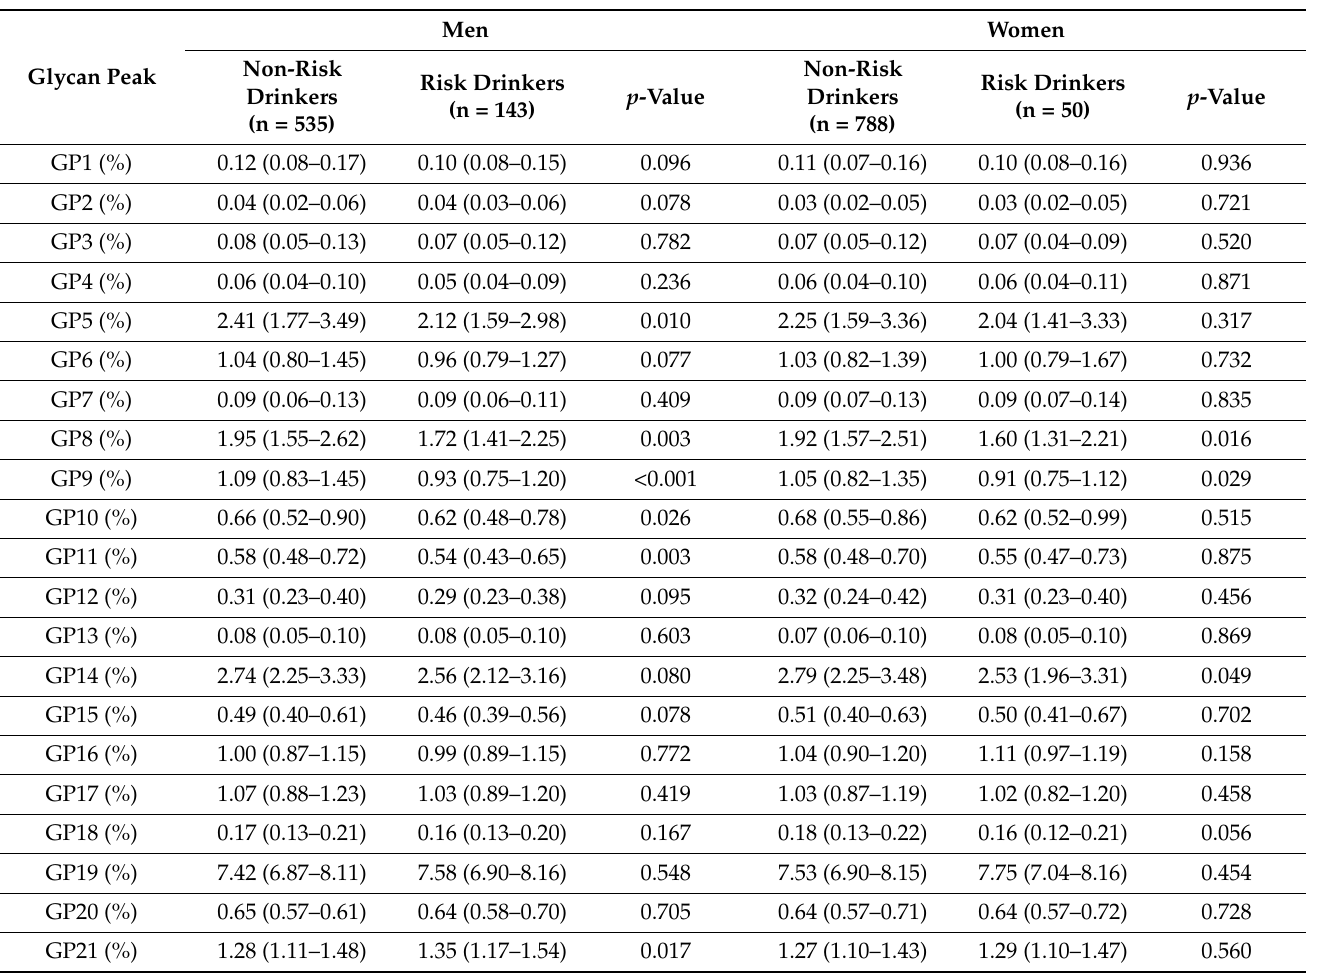
Table 3. Comparison of N -glycan peaks between risk drinkers and non-risk drinkers, stratified by